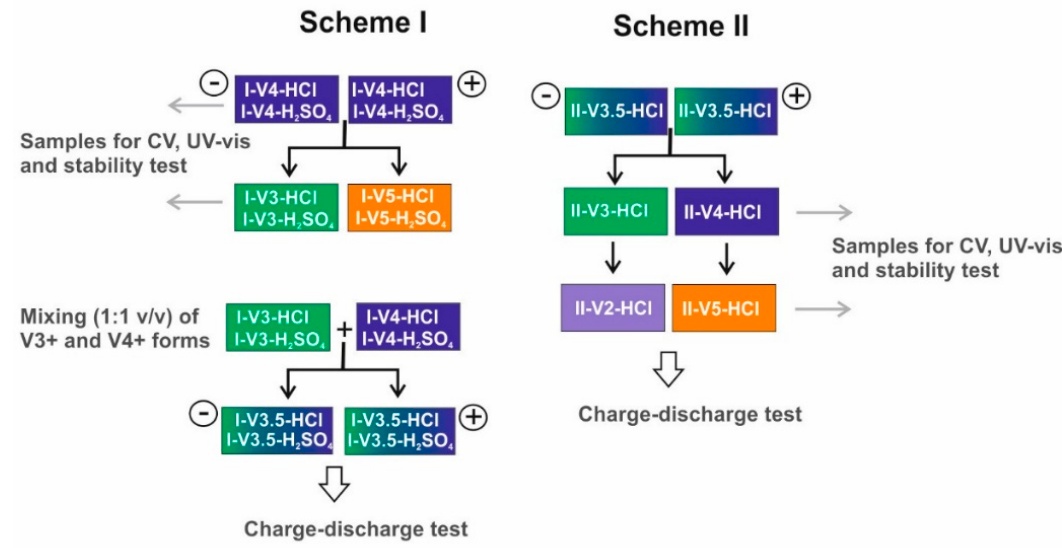
Figure 5. Schematic representation of the preparation pathways for electrolyte samples (series I and II). Table 6. The amounts of reagents used for the preparation of initial vanadium electrolyte solutions. Sample